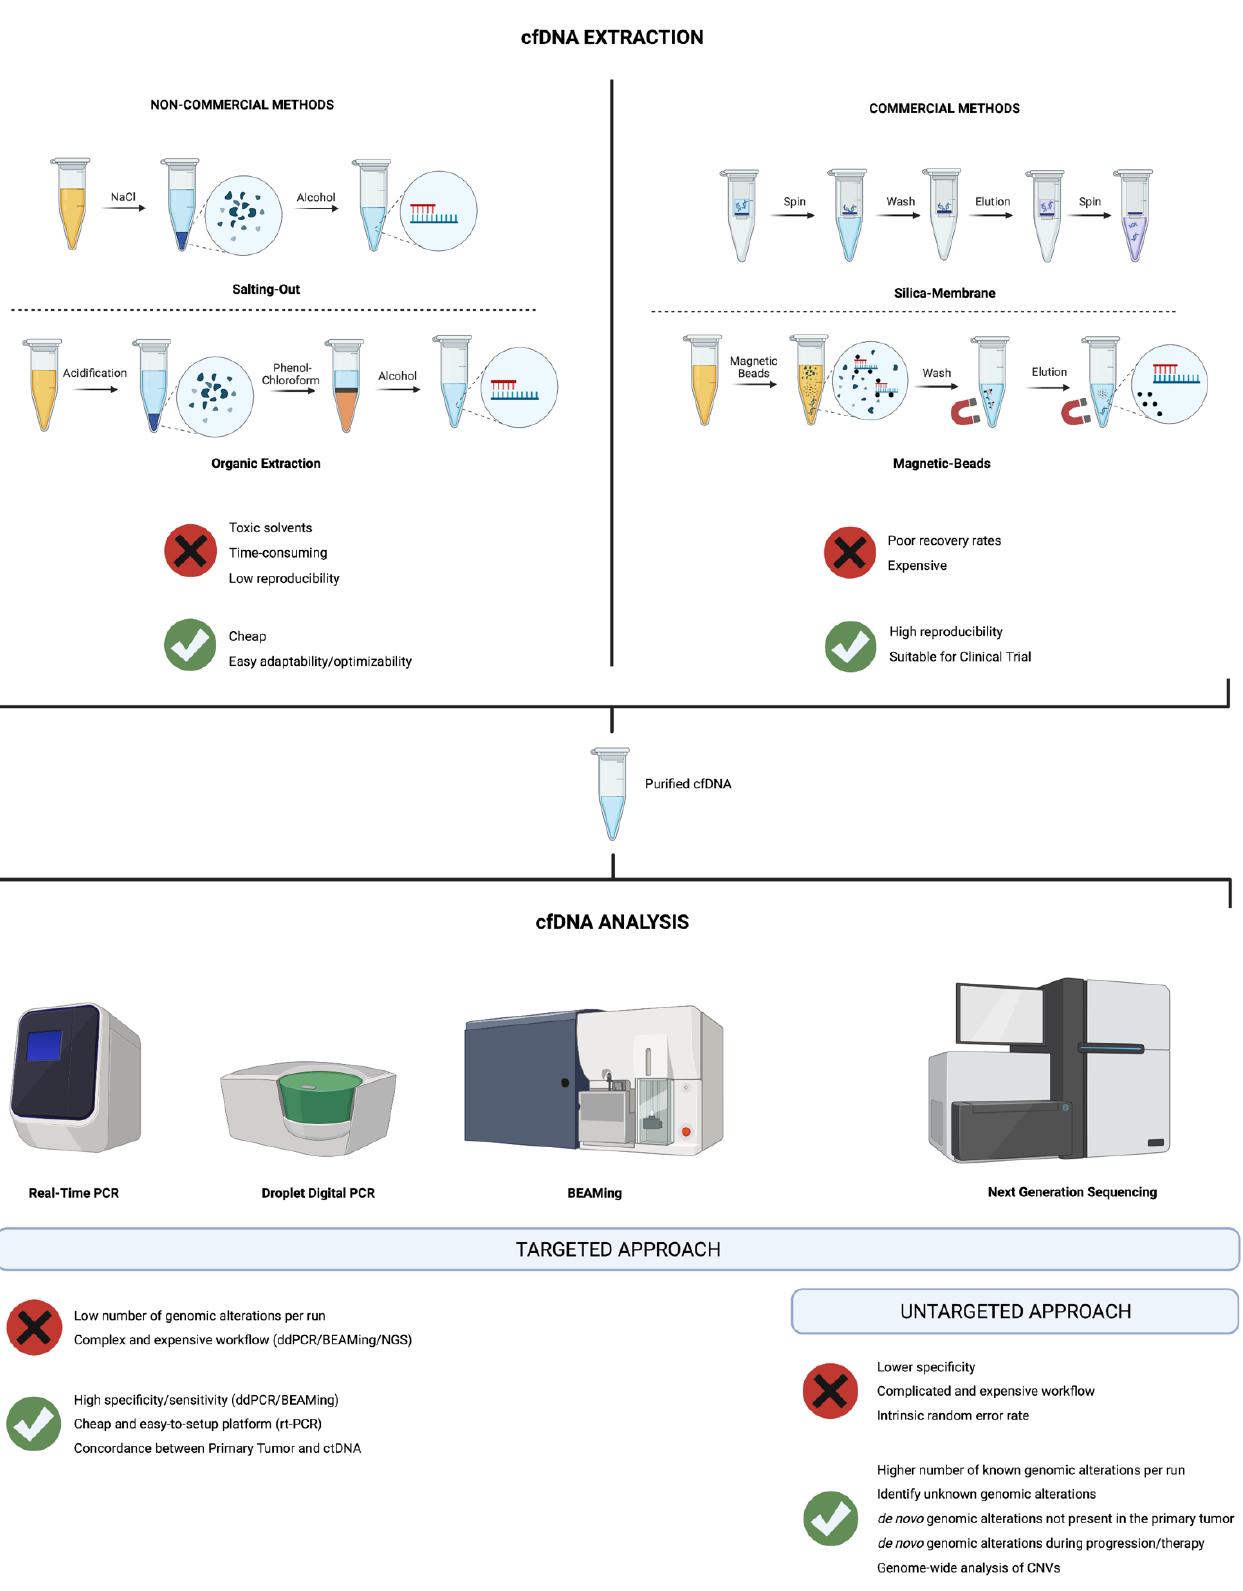
Figure 1. Graphical representation of the cfDNA extraction methods and analysis approaches. Advantages and disadvantages are highlighted for each